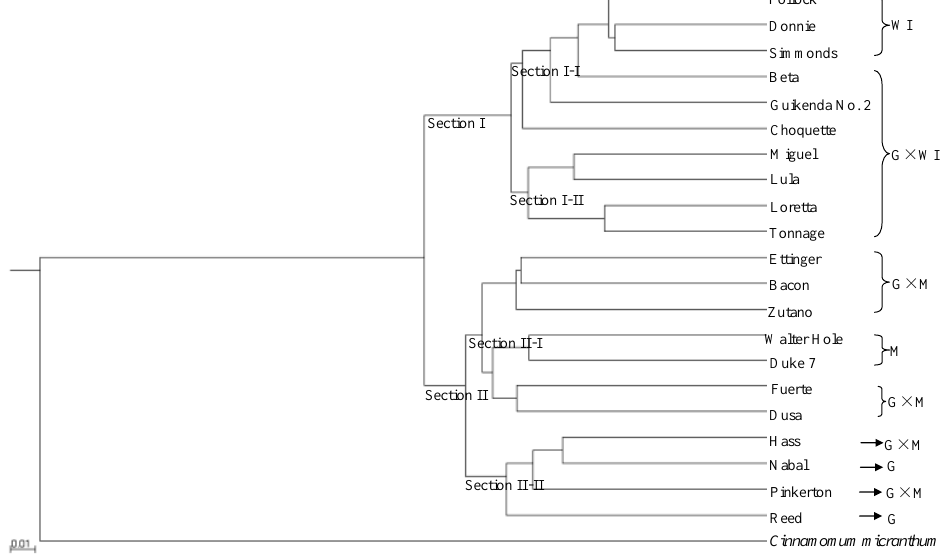
Figure 1. Rooted unweighted pair-group method with arithmetic means (UPGMA) phylogenetic tree of 21 avocado accessions based on 701,352 single nucleotide polymorphisms (SNPs) from specific length amplified fragment sequencing (SLAF-seq). M: Mexican, G: Guatemalan, WI: West Indian (interracial hybrids are indicated by × ).